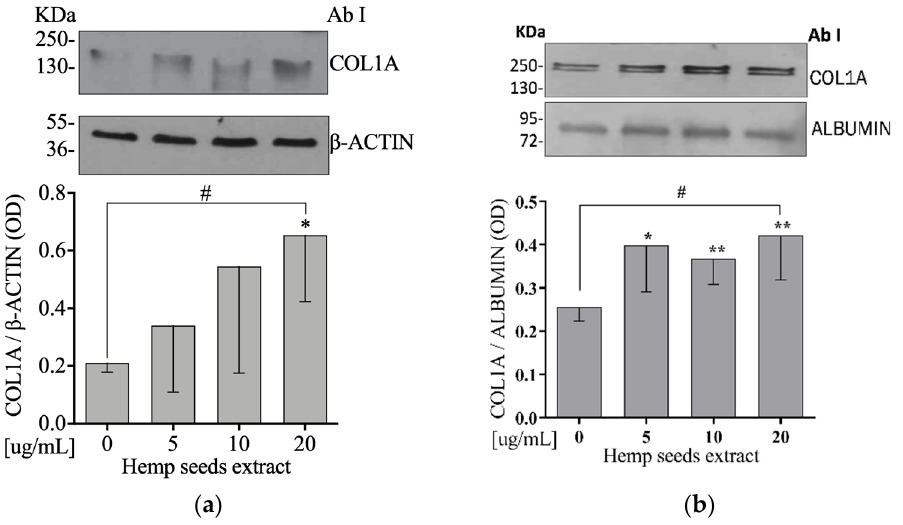
Figure 5. HSE increases intra- and extracellular COL1A protein levels on Saos-2 cells. Semi-confluent cultures of human osteoblast-like cells (Saos-2) were incubated with HSE 5, 10, or 20 µg/mL for 24 h. Cell and medium proteins (( a , b ), respectively) were analyzed by Western blotting, with antibodies specific to COL1A, β -actin, and Albumin. Data are represented as mean ± SD. Statistical analysis: Student’s t -test vs. 0 * p < 0.05 ** p < 0.01, Linear regression # p < 0.05.